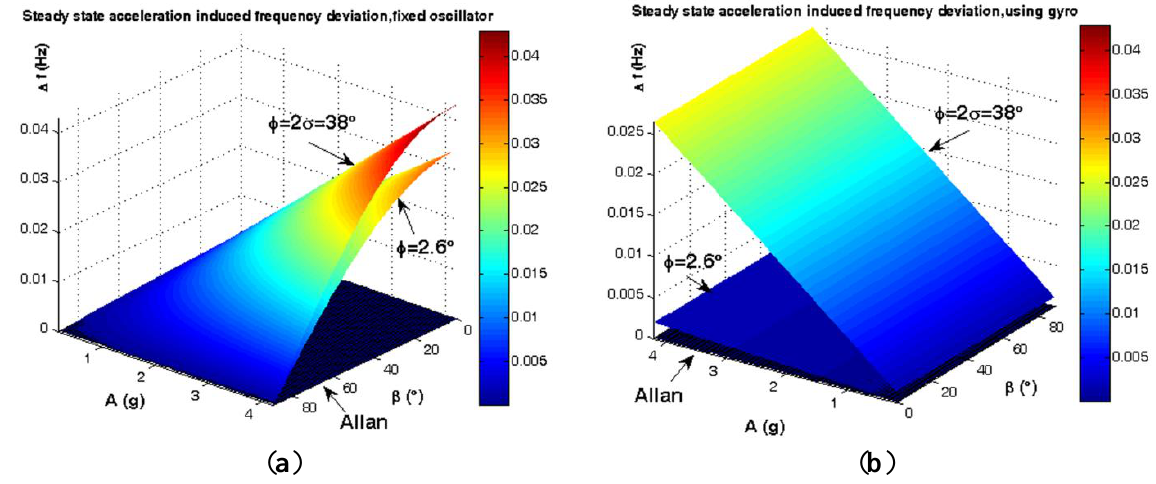
Figure 12. Comparison between steady state load-induced frequency deviation and Allan safety margin. ( a ) Fixed oscillator; ( b ) Gyroscopic